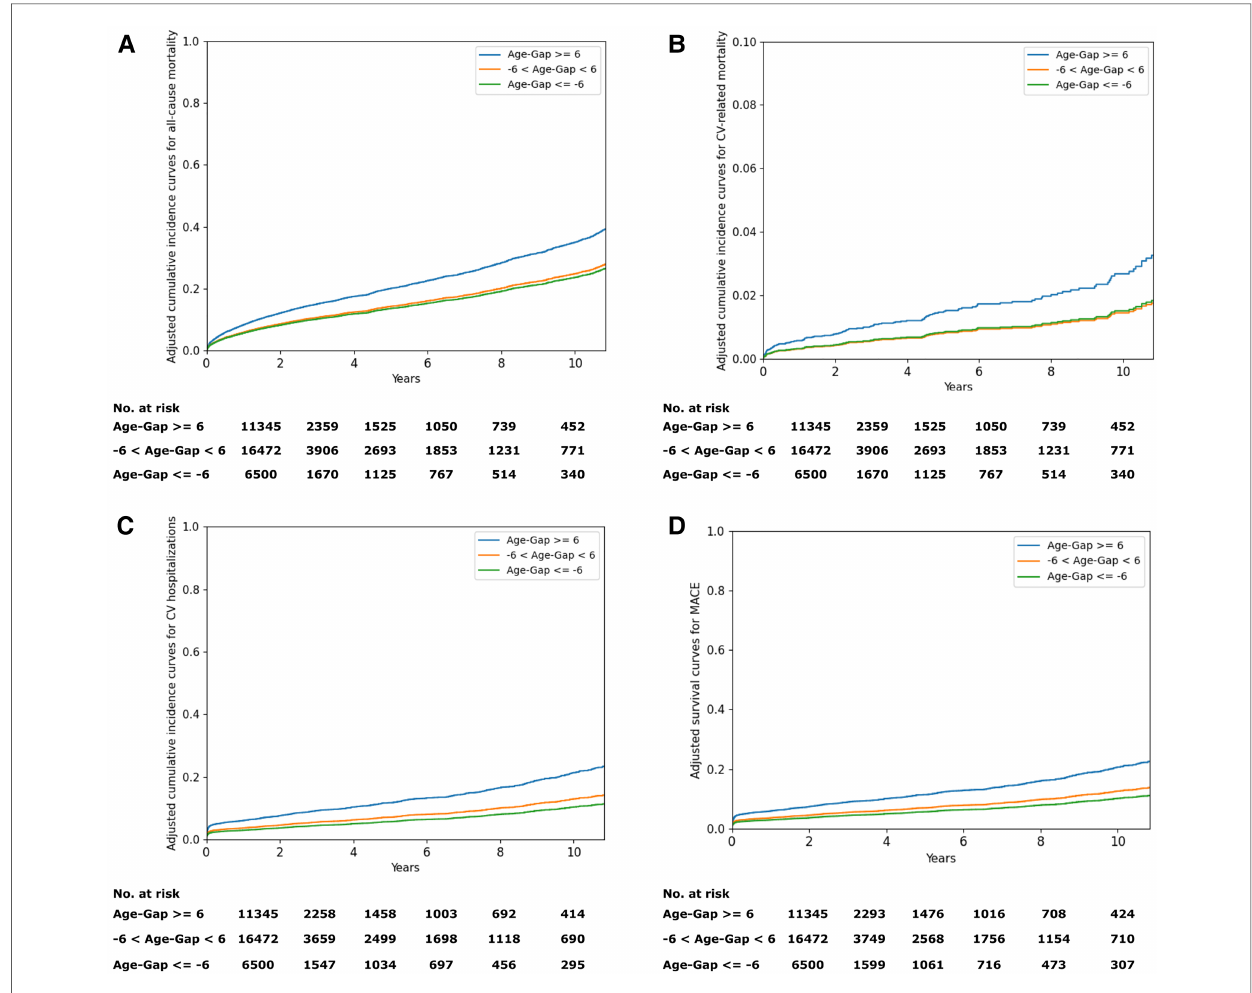
FIGURE 4 ( A ) Adjusted cumulative incidence curves for all-cause mortality. ( B ) Adjusted cumulative incidence curves for cardiovascular-related mortality. ( C ) Adjusted cumulative incidence curves for cardiovascular hospitalizations. ( D ) Adjusted survival curves for MACE. MACE, major adverse cardiovascular